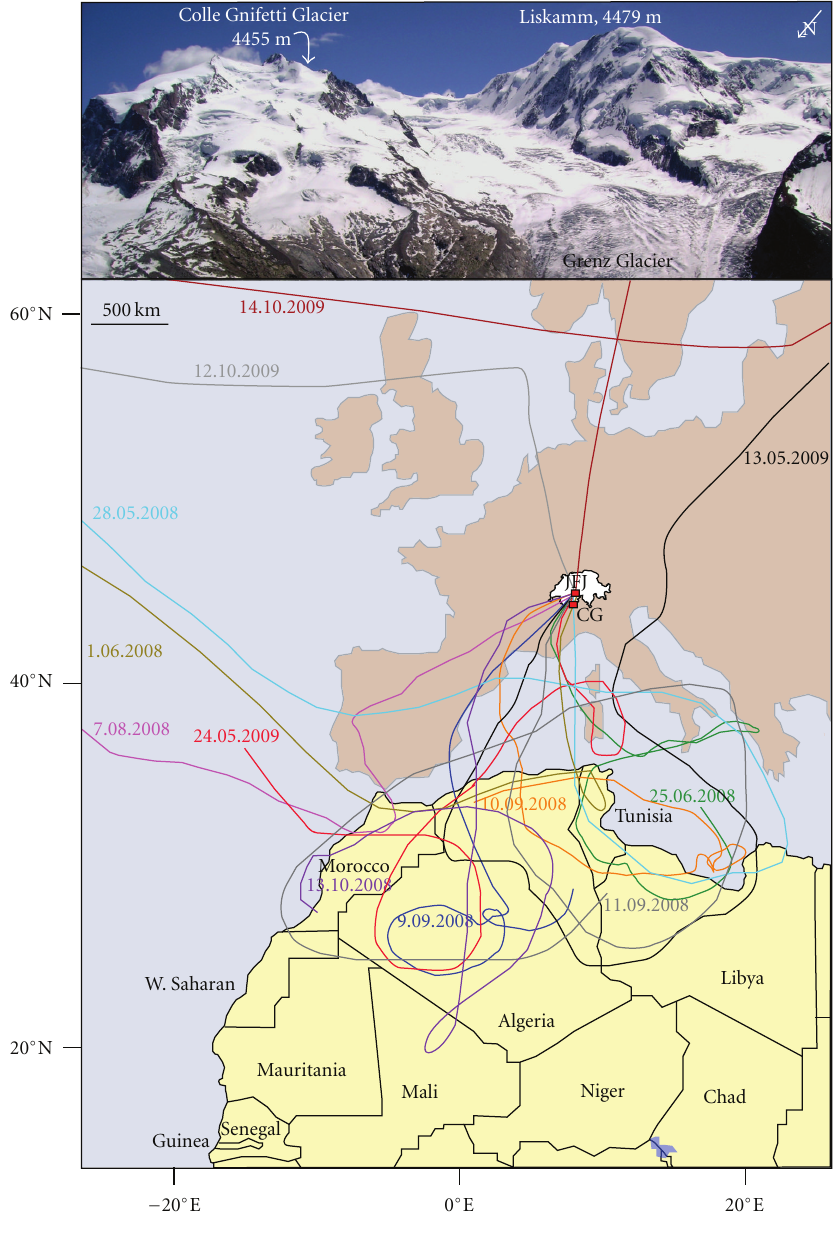
Figure 1: (Top) Panorama from the south of the Monte Rosa Massif showing the location of the ice core site (Colle Gnifetti glacier, CG) and the Grenz Glacier. (Bottom) Geographical map showing the 315-hour backward trajectories arriving at Jungfraujoch (JFJ), reconstructed using the NOAA HYSPLIT model